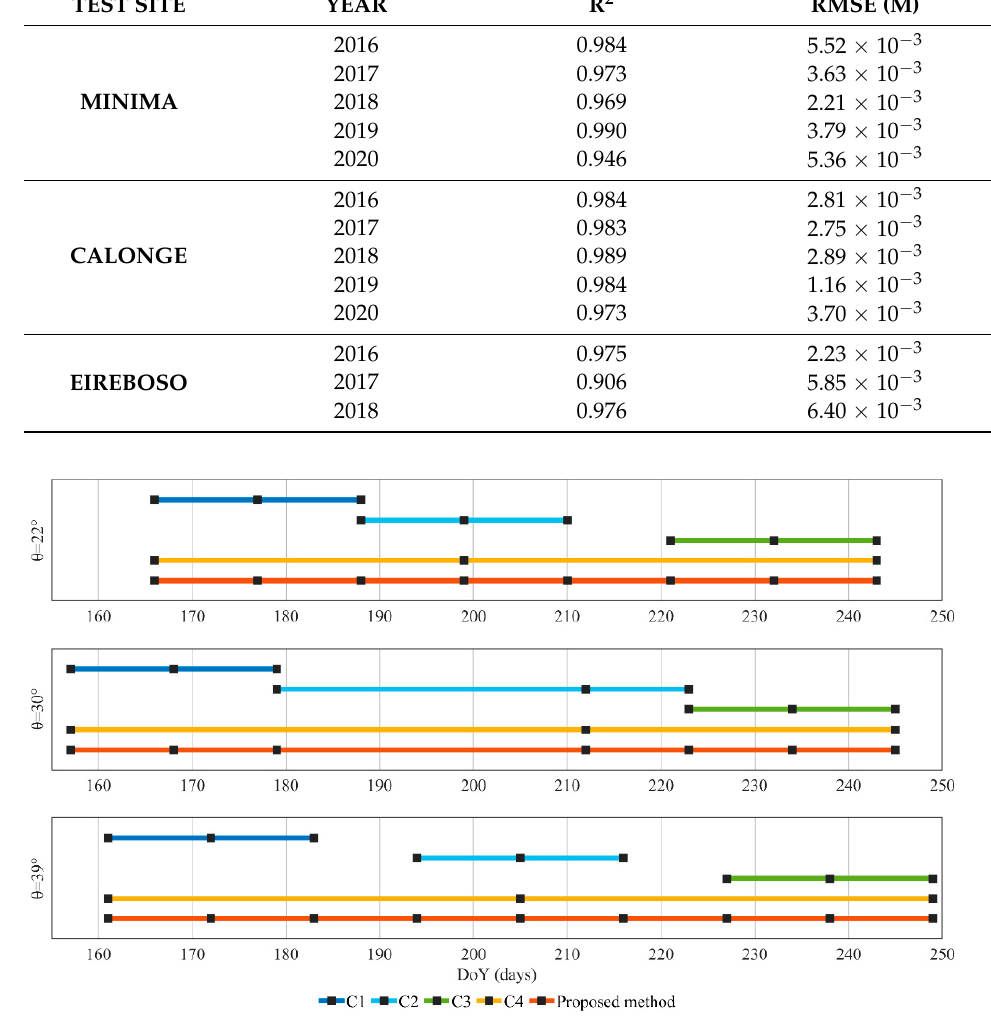
Figure 6. Graphical representation of the different combinations of dates (black squares) chosen to compare to the proposed method with 22 ◦ , 30 ◦ , and 39 ◦ incidence angles. C1–C4 display the three interferograms selected as the input data. The proposed method (red) corresponds to the strategy of choosing inputs from all the observations available.